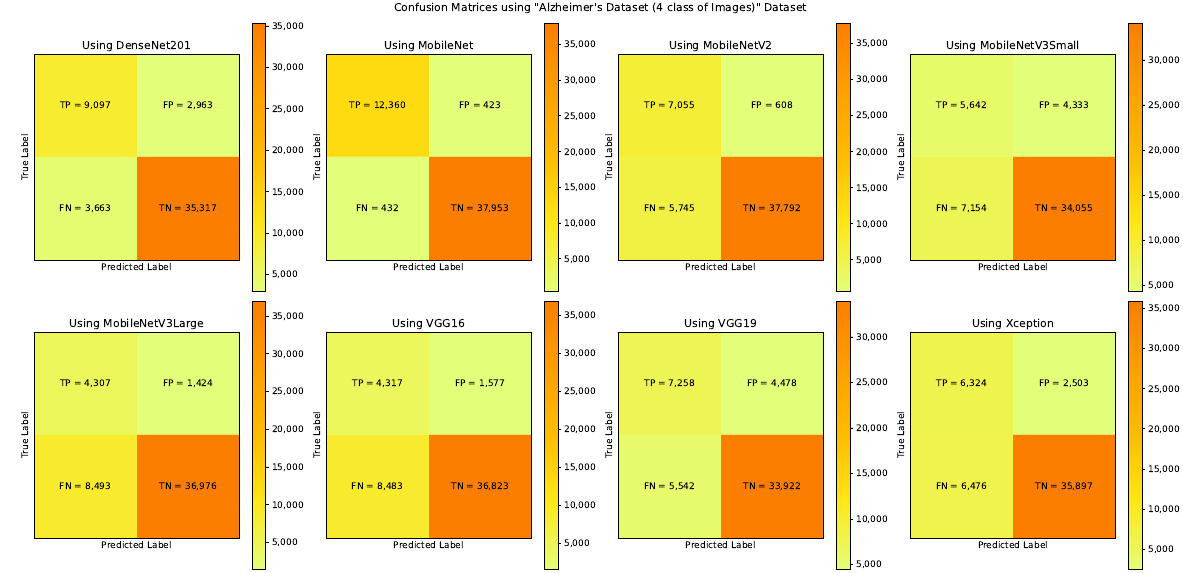
Figure 9. The confusion matrices using the “Alzheimer’s Dataset (4 class of Images)”